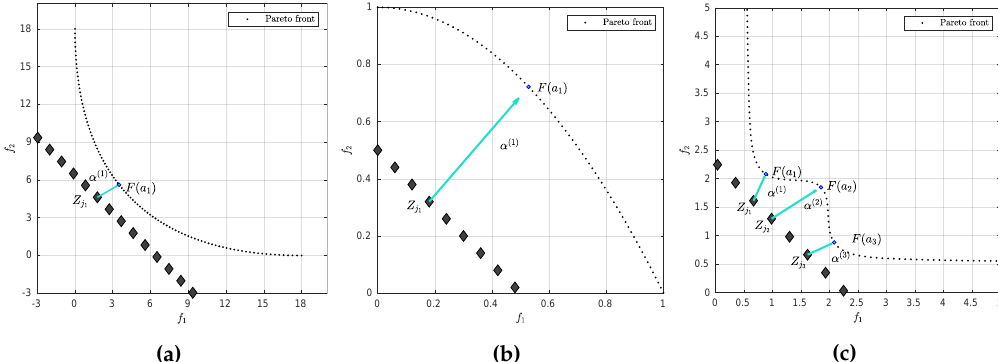
Figure 2. Geometrical interpretation of the optimality condition (ii) for GD 2 to the linearized Pareto front. ( a ) shows this behavior on a concave Pareto front, ( b ) on a convex Pareto front, and ( c ) on a concave/convex Pareto